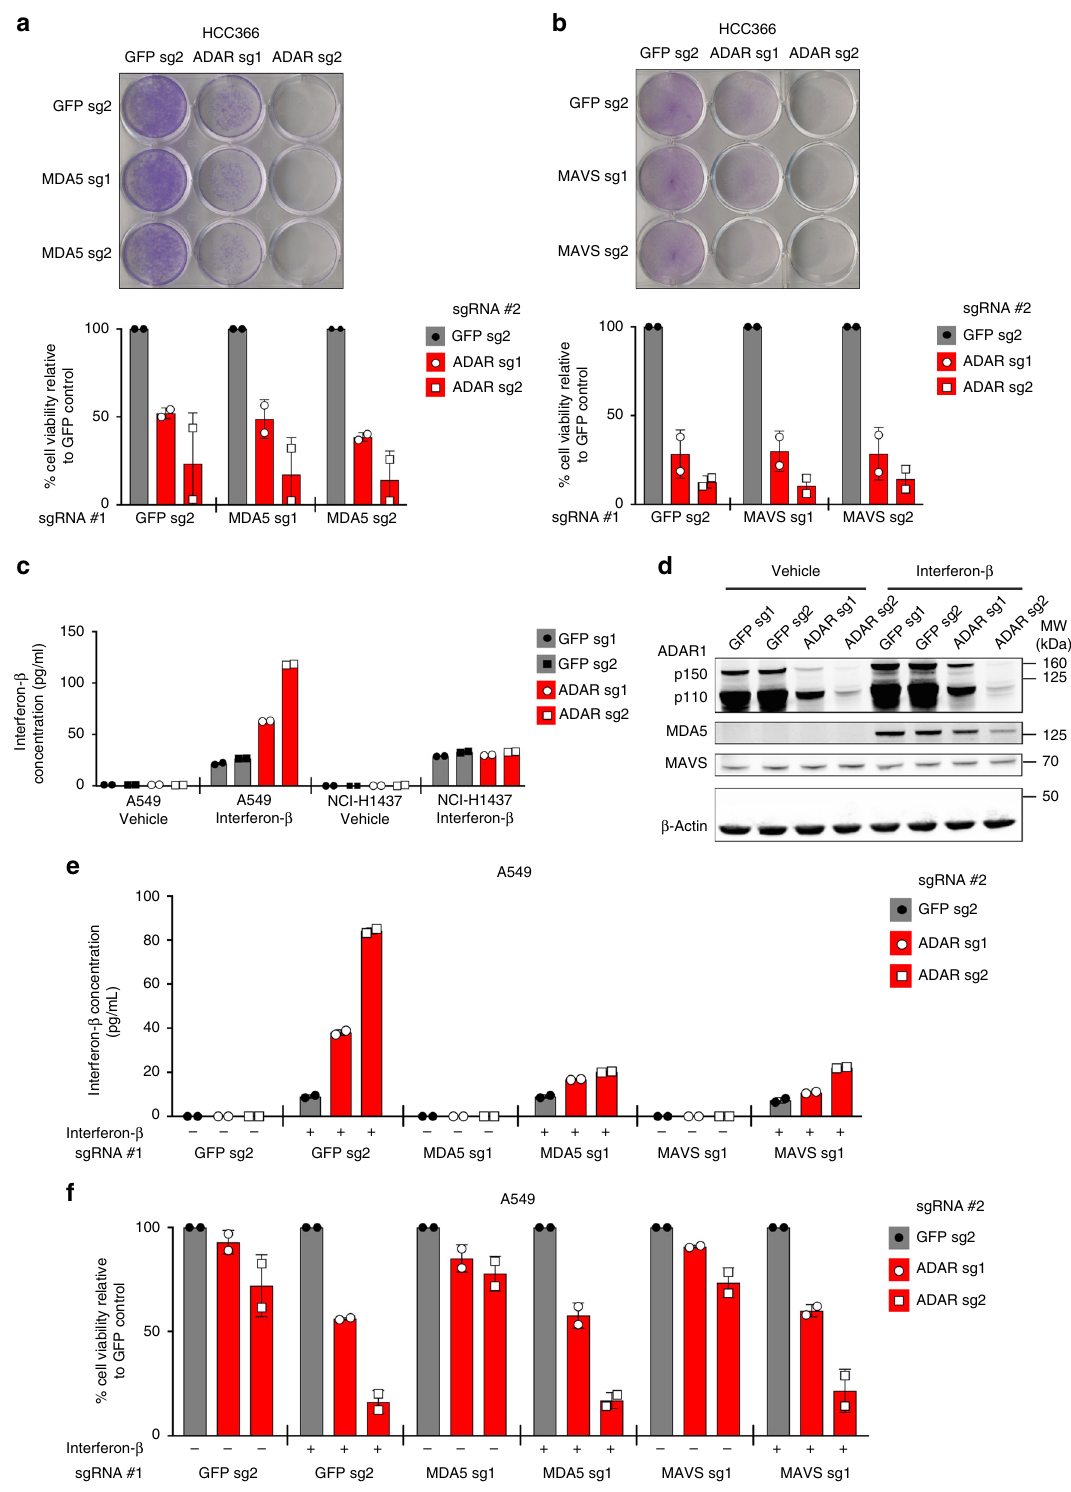
lethality in Adar1 − / − mice 11,12,19 . Notably, MDA5 gene expres- sion and protein levels correlate with ADAR KO-sensitivity across a spectrum of cancer cell lines (Fig. 1c and Supplementary Fig. 3a, b). However, deletion of neither MDA5 nor MAVS could rescue cell lethality after ADAR knockout in the cell lines tested (Fig. 2a, b and Supplementary Fig. 3c – f), indicating that MDA5/MAVS signaling is dispensable for this